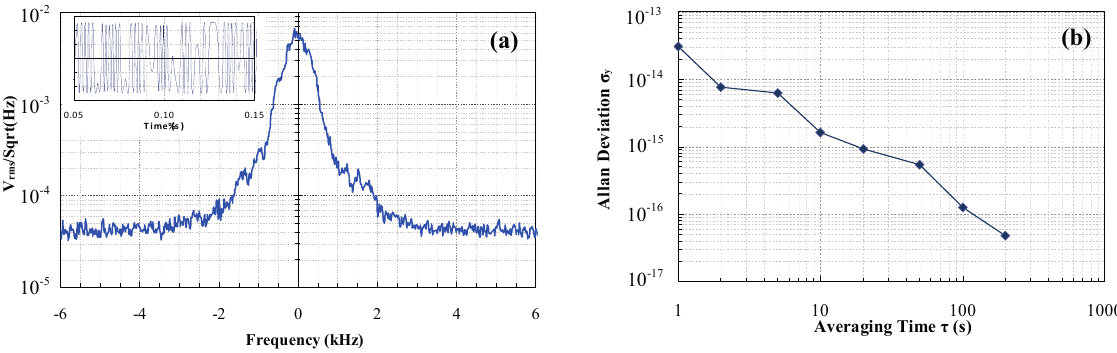
Figure 5. ( a ) A typical spectrum of the transmission-broadened optical clock signal. Inset: a time-domain trace of the beat note between the recovered clock and the original clock; ( b ) A typical Allan deviation measurement